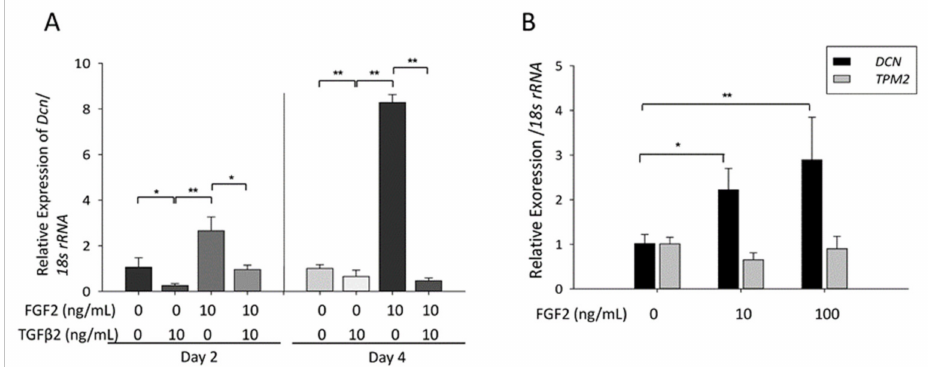
Figure 3. Expression of Dcn and Tpm1 in cultured mouse lens epithelial cells (MLECs) and human mouse lens epithelial cells (HLECs) after treatment with FGF2 with/without TGF β -2. ( A ) Cultured MLECs were plated in 35-mm dishes at the density of 1 × 10 5 in Dulbecco’s modified Eagle’s media (DMEM) with 10% FBS for 24 h. LECs were treated with 10 ng/mL TGF β -2 and/or 100 ng/mL FGF2 in DMEM containing 1% FBS for 2 and 4 days. The relative quantity of Dcn mRNA was determined using RT-qPCR analysis. * p < 0.004, ** p < 0.001. ( B ) Cultured HLECs were plated in 35-mm dishes at the density of 8 × 10 4 in DMEM with 20% FBS for 24 h. LECs were treated with 0–100 ng/mL FGF2 in DMEM containing 1% FBS for 2 days. Relative quantity of Dcn and Tpm1 mRNA was determined using RT-qPCR analysis. * p < 0.004, ** p < 0.05. Data were from three experiments and were reported as mean ± S.D. M: marker.